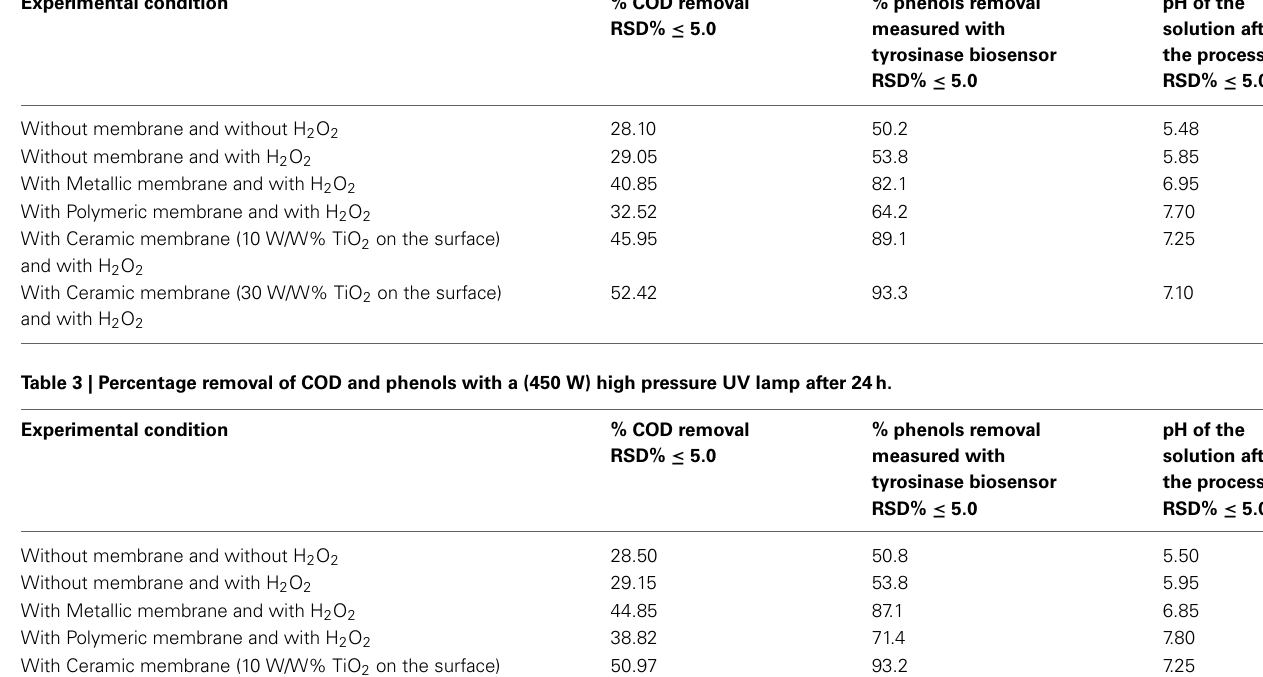
Table 2 | Percentage removal of COD and phenols with a (36 W) low pressure UV lamp after 24h. Experimental condition